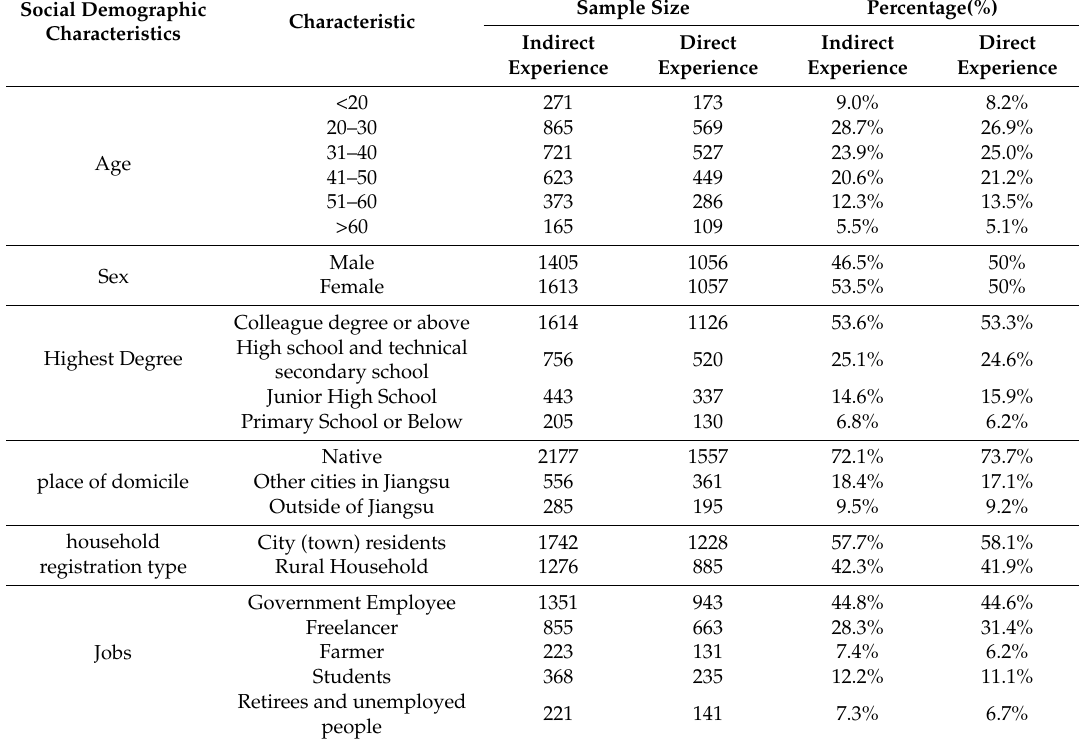
Table 1. Comparative statistics of personal characteristics of sample respondents with or without direct experience.